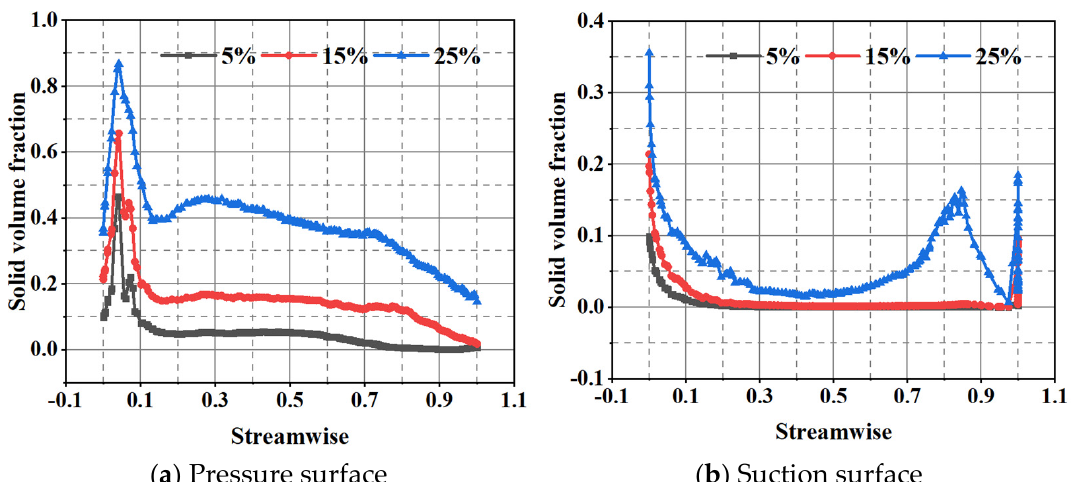
Figure 11. ( a , b ) Solid volume fraction distribution of blade.